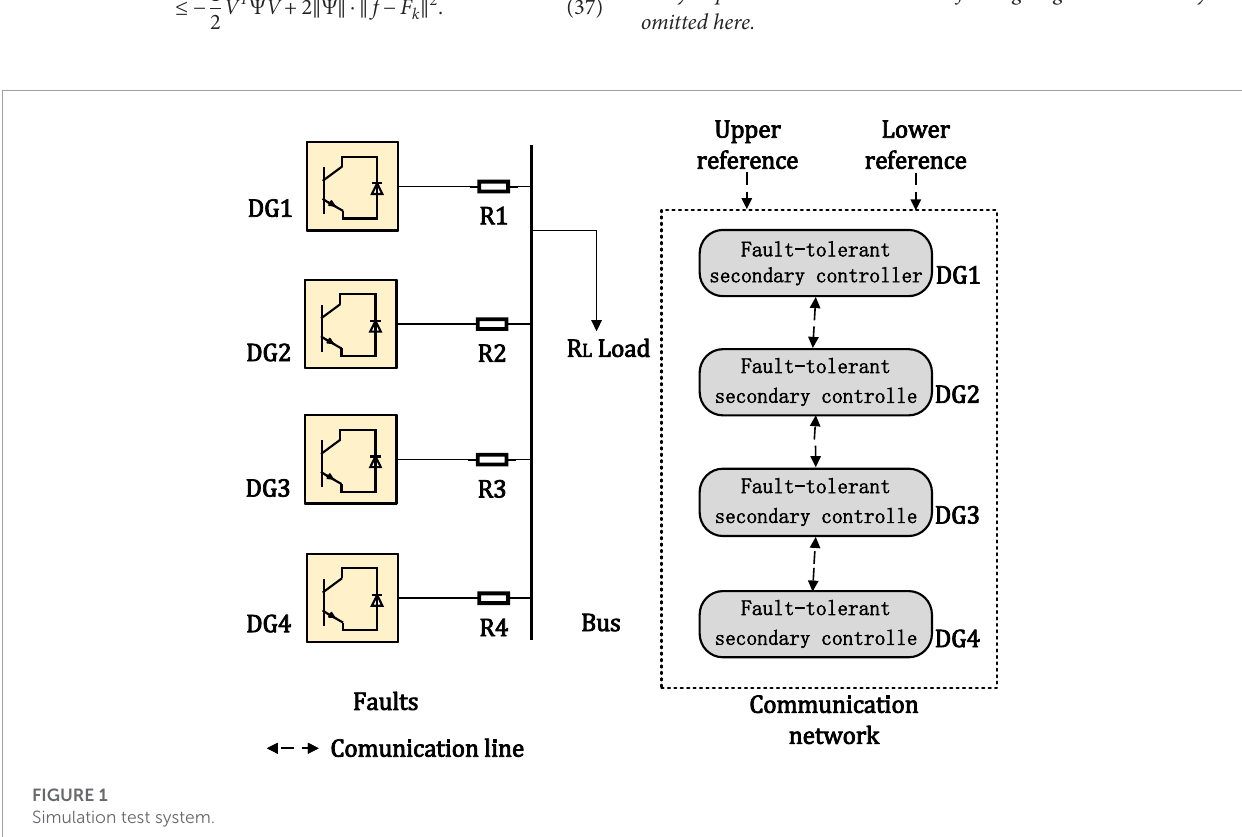
FIGURE 1 Simulation test